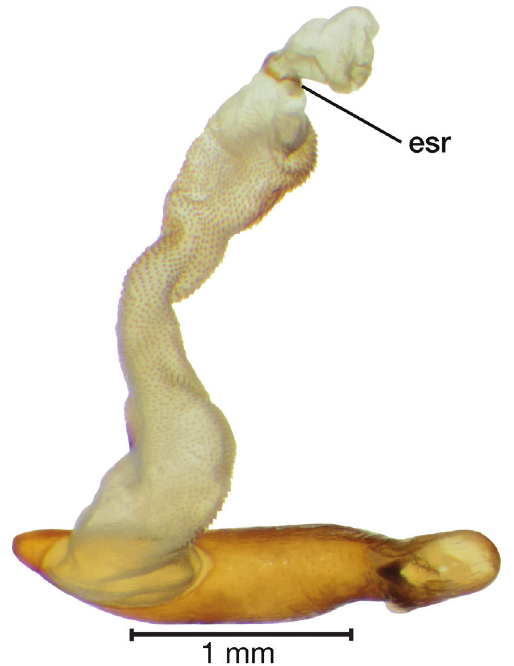
Figure 42. Digital image of male genitalia of C. ( Coptoderina ) japonica Bates, ventral aspect, endophallus everted. Legend: esr endophallic sclerotized